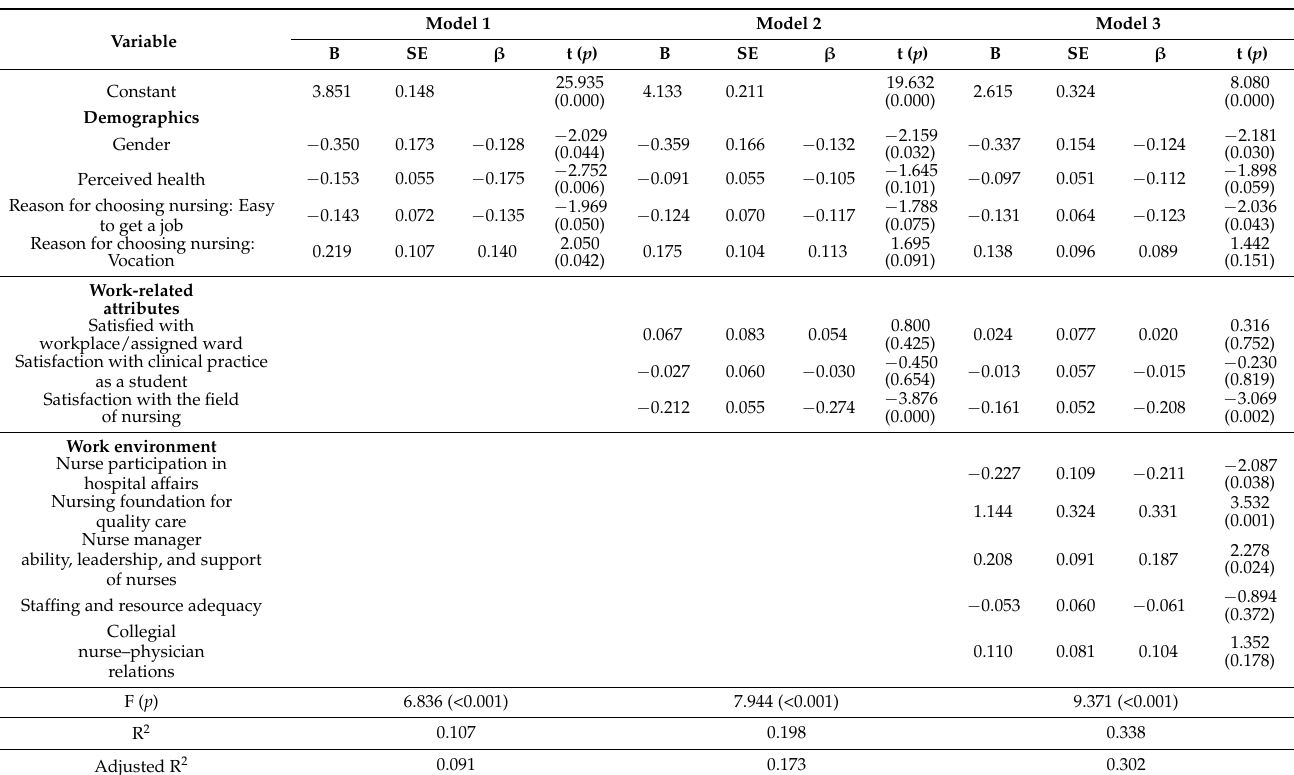
Table 3. Factors affecting nurses’ resilience ( n =